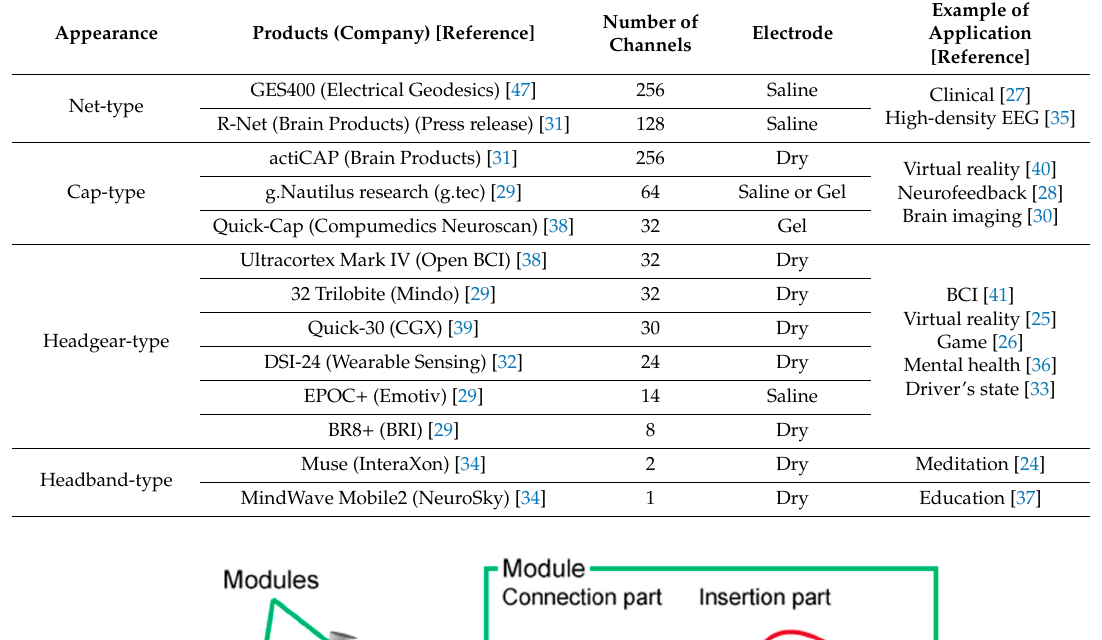
Table 1. Existing methods used in current electroencephalogram (EEG) devices.